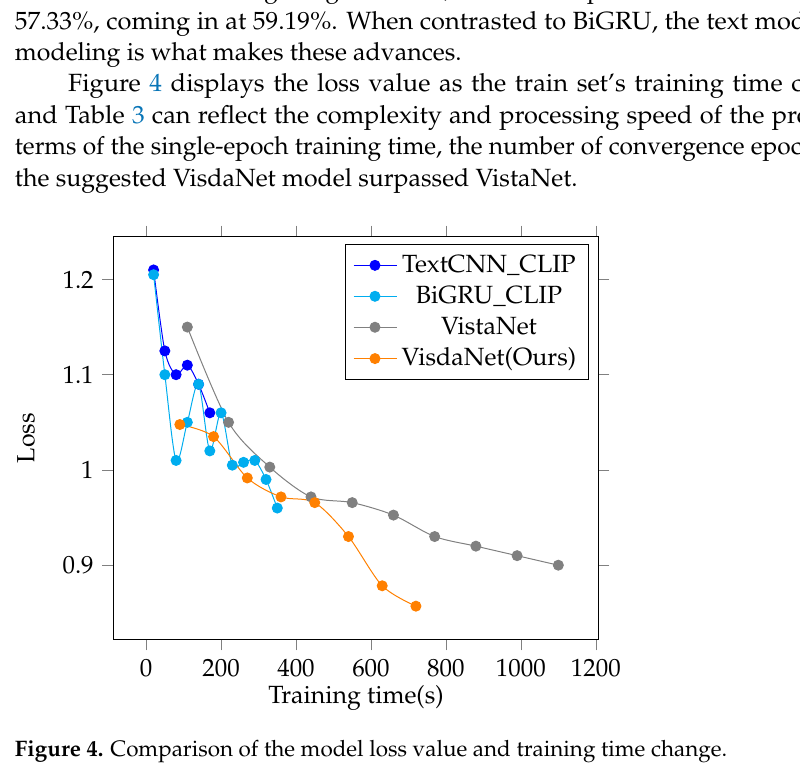
Figure 4. Comparison of the model loss value and training time